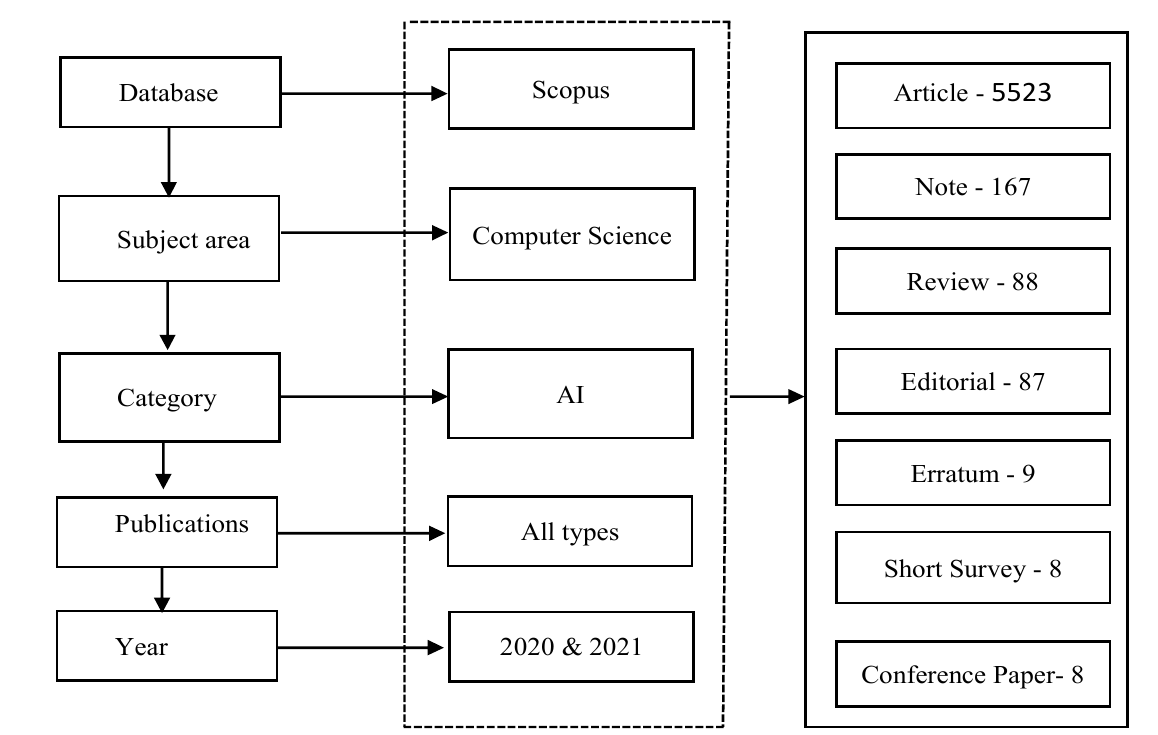
Figure 1. Data collection process.